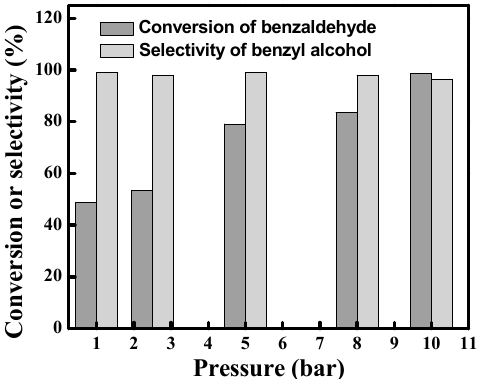
Figure 1. Results of the reduction of benzaldehyde at di ff erent hydrogen pressure. Reaction